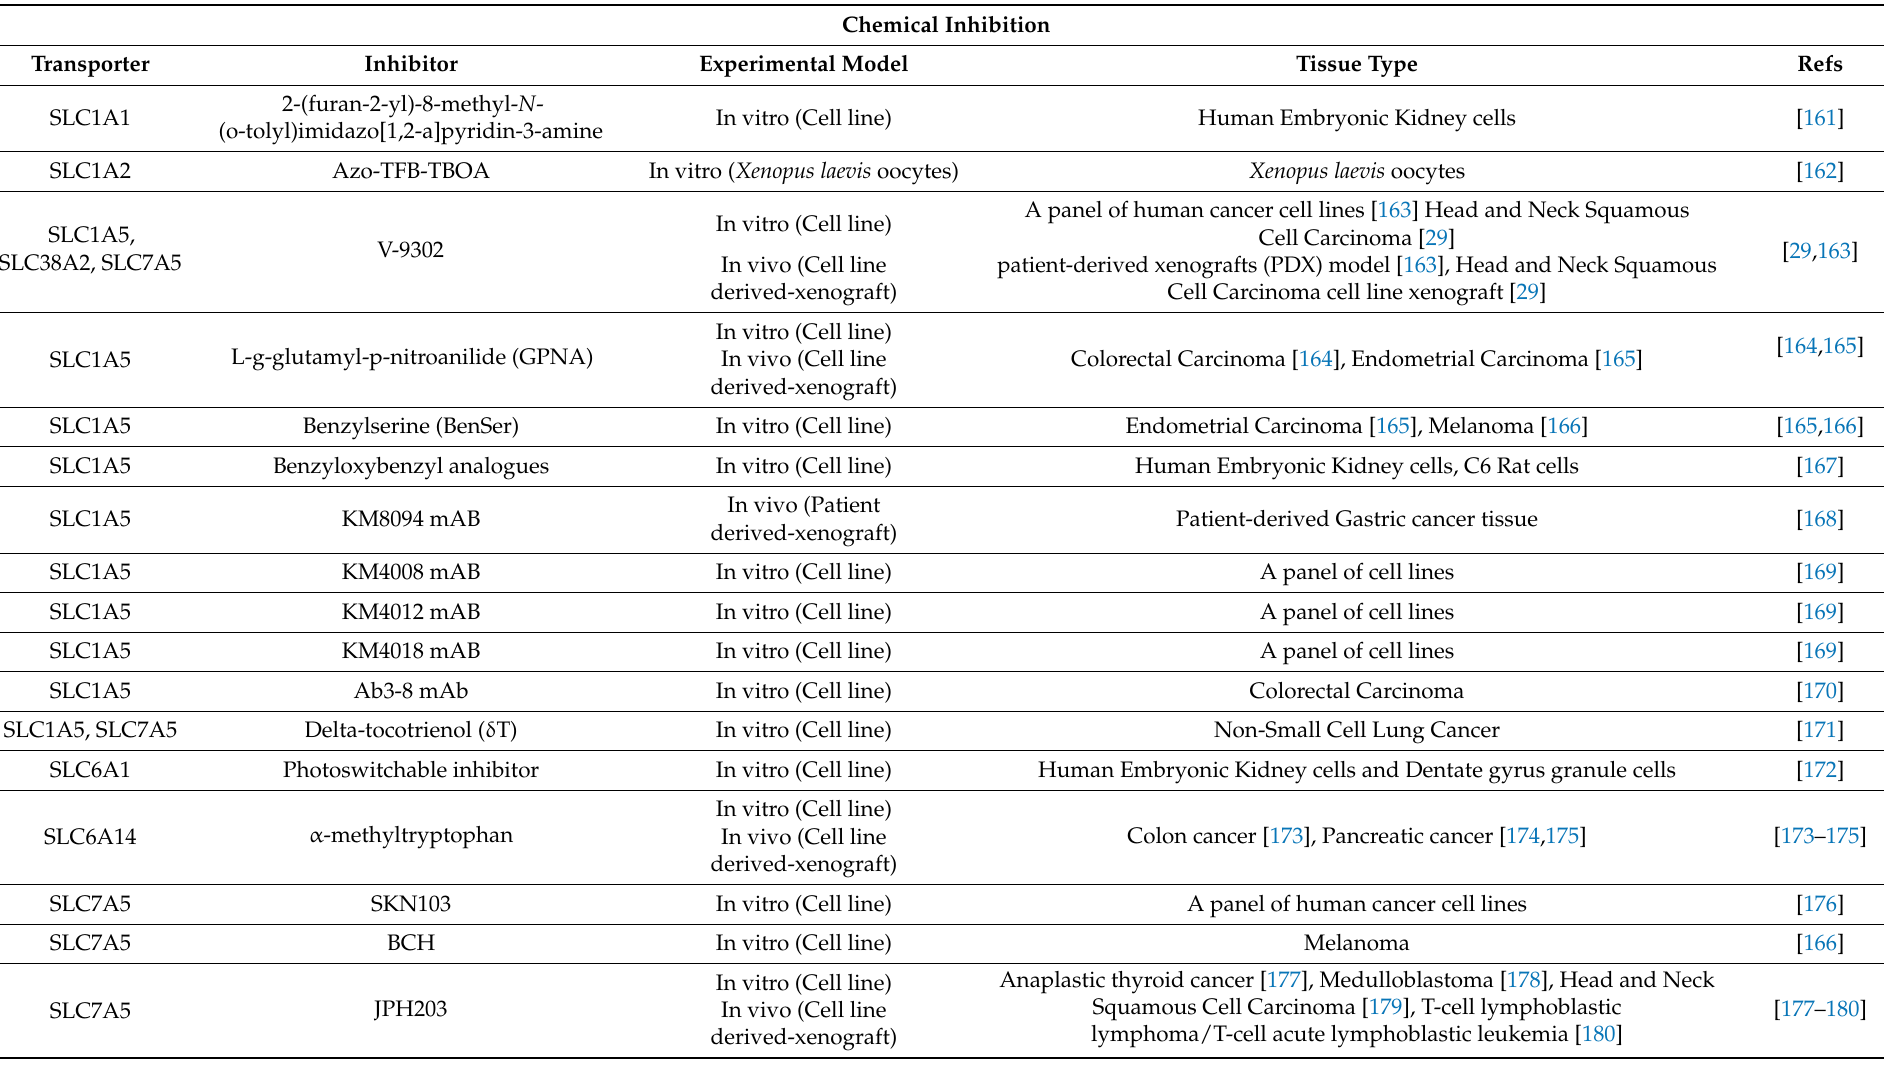
Table 1. Targeting of the amino acid